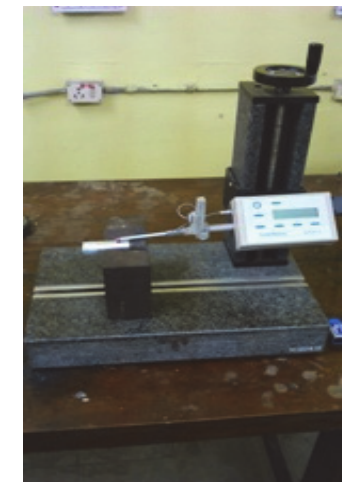
Fig. 2. Photographic view of position of accelerometer on tool holder Experimental data of surface roughness (Ra) and tool vibrations (V) corresponding to Box-Behnken design of experiment Experiment